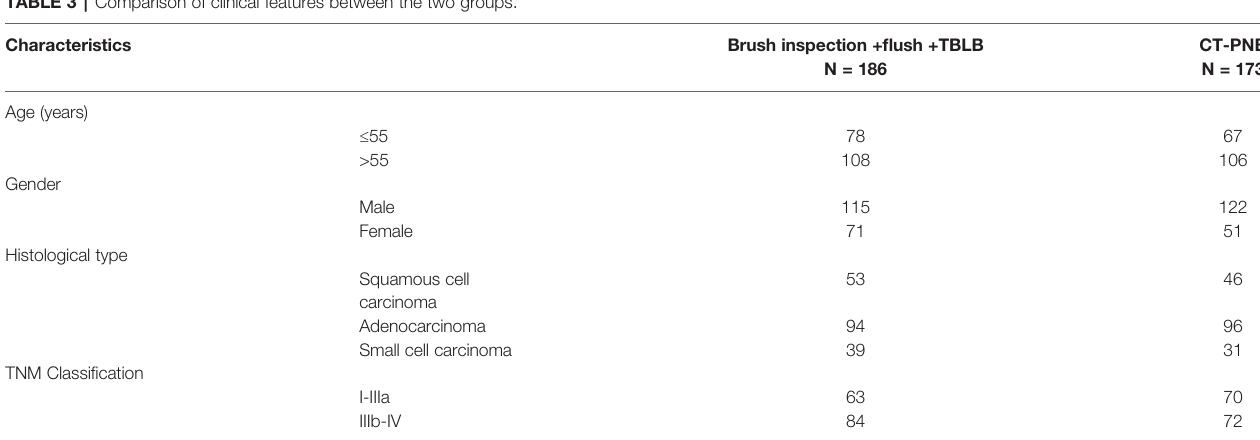
TABLE 3 | Comparison of clinical features between the two groups. Characteristics